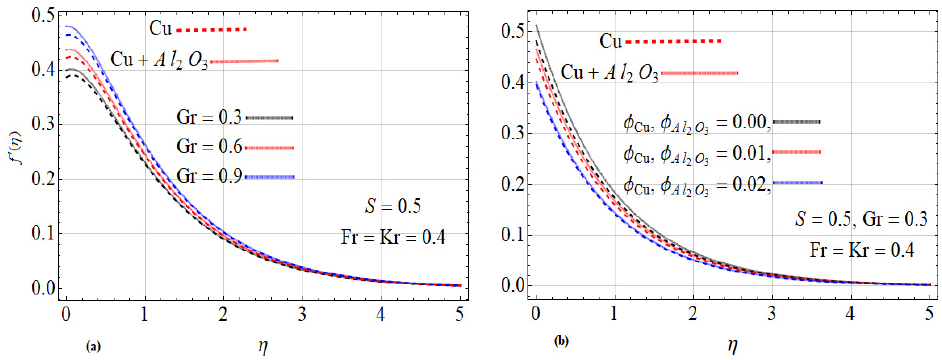
Figure 4. ( a , b ) Impact of Gr , φ Cu , φ Al